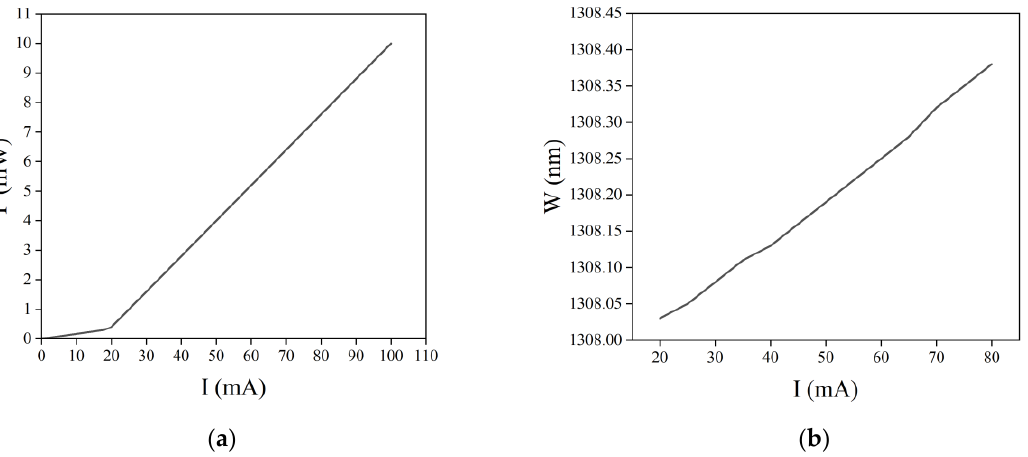
Figure 1. Current characteristics of semiconductor lasers: ( a ) P-I characteristic curve and ( b ) W-I characteristic curve.